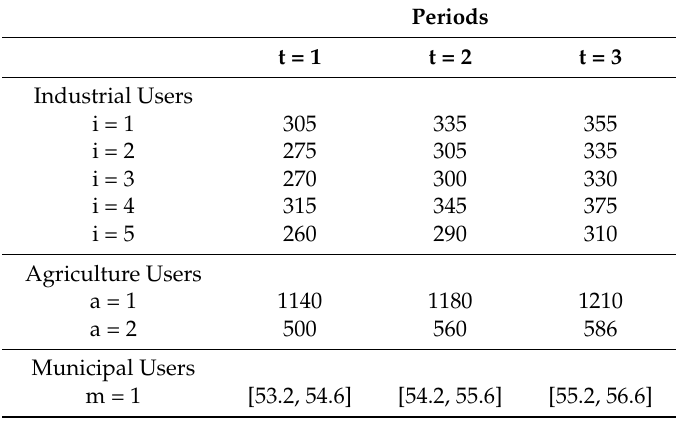
Table 1. Water planning targets for users (10 6 m 3 ).